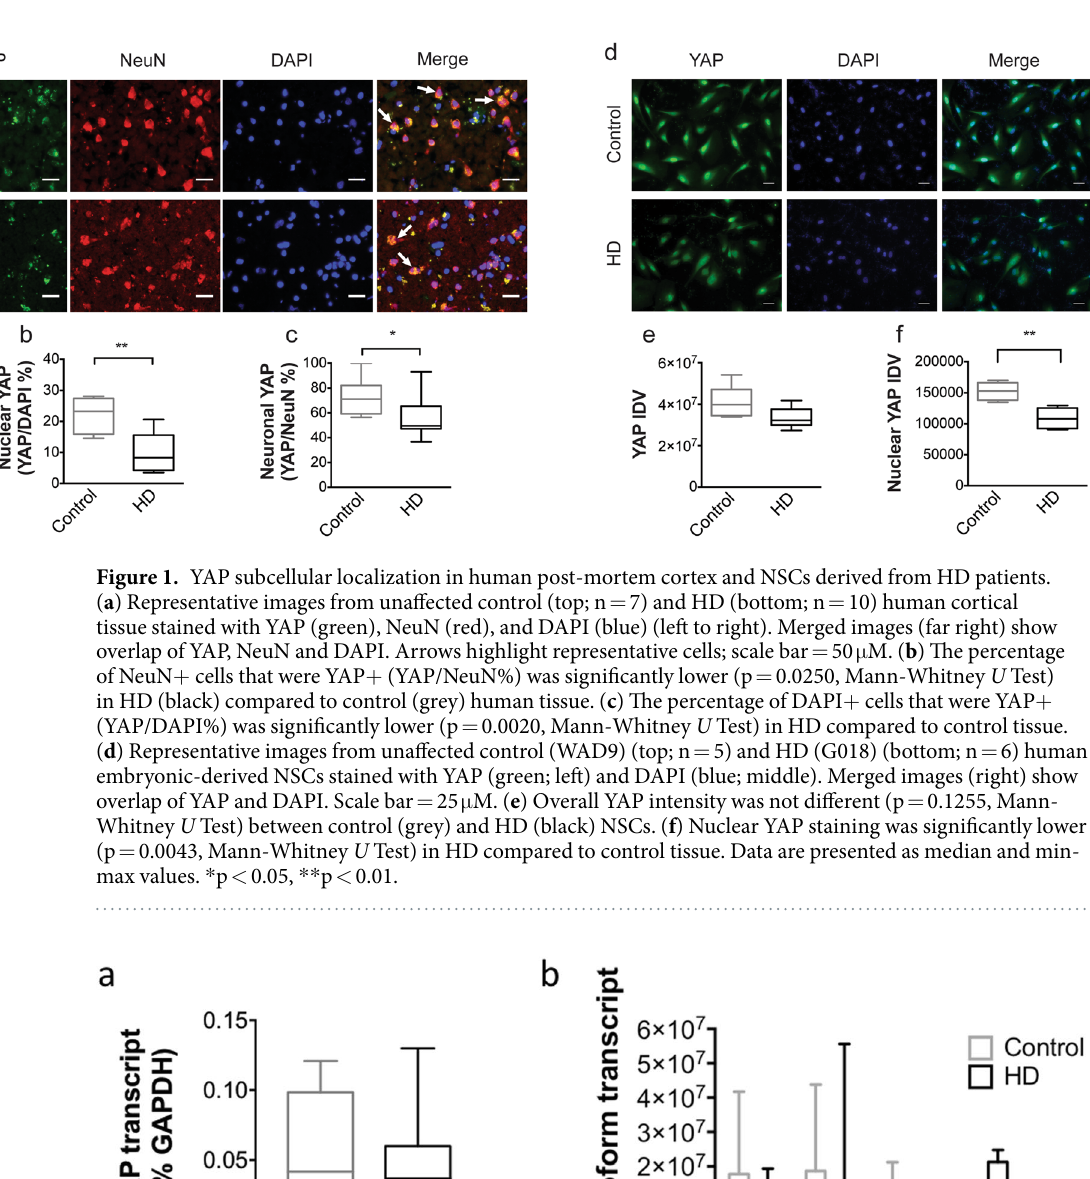
samples using PCR with the previously published YAP Δ C primers 25 . A two-way ANOVA demonstrated that there was no significant effect of genotype [F(3, 68) = 0.779, p = 0.512], YAP isoform [F(1, 68) = 0.282, p = 0.597], or interaction [F(3, 68) = 0.383, p0.765] in 11 HD compared to 8 control samples (Fig. 2b) demonstrating that YAP Δ C isoforms are not altered in HD in our post-mortem samples.